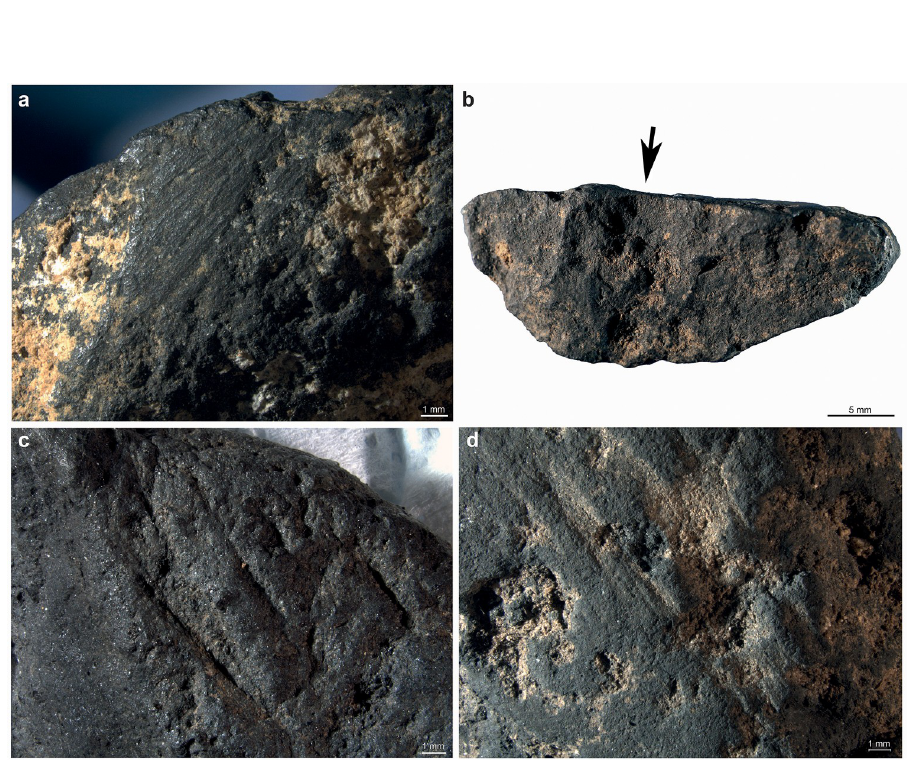
Fig 3. Traces of modifications identified on manganese-rich rocks. Modification types identified on manganese-rich rocks from Le Moustier. (a) Abrasion, (b) percussion, (c) notching, (d)